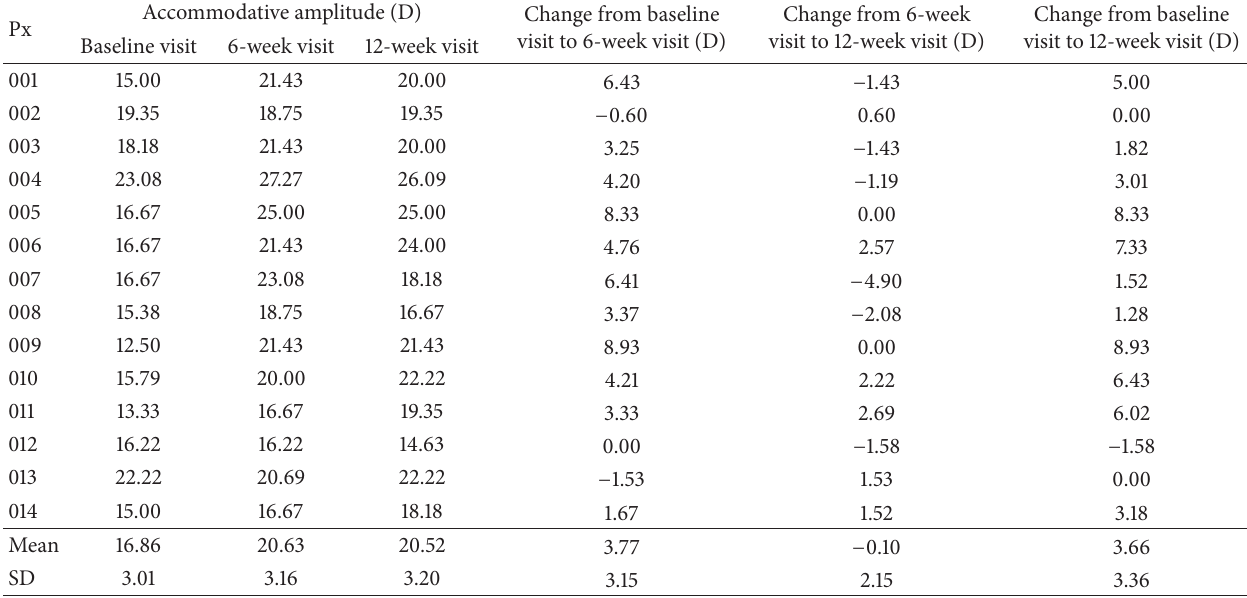
Table 3: Result and comparison of monocular accommodative amplitudes at different visits.